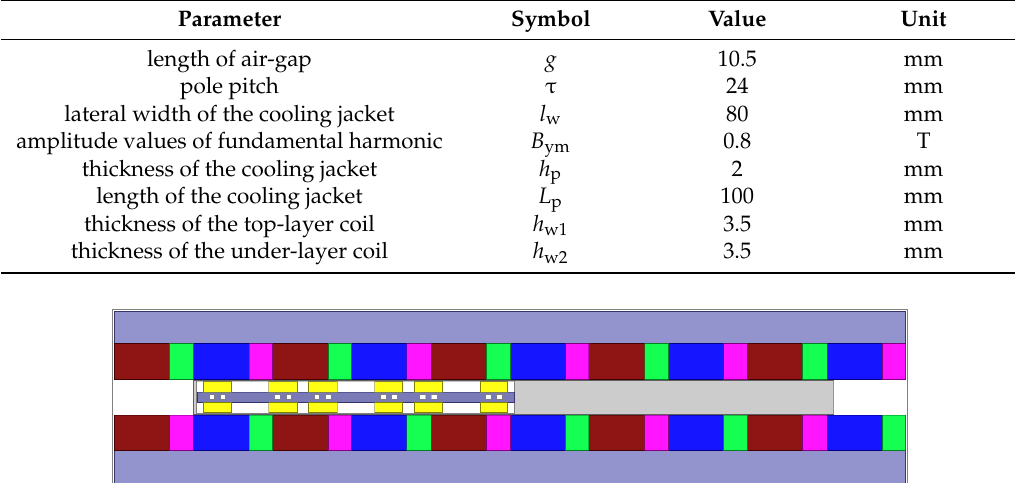
Table 1. Parameters dimension of the finite element simulation model of the PMLSM.